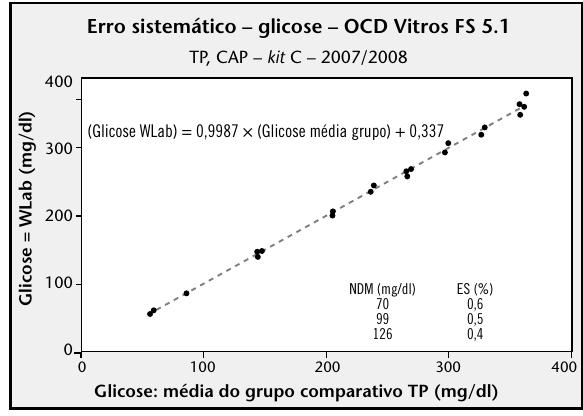
Figura 5 – Análise de inexatidão de longo prazo: determinação de ES por meio do modelo de regressão linear (mínimos quadrados), glicose Vitros FS 5.1, SDI TP, CAP, kit C, 2007/2008 NDM: nível de decisão médica; ES: erro